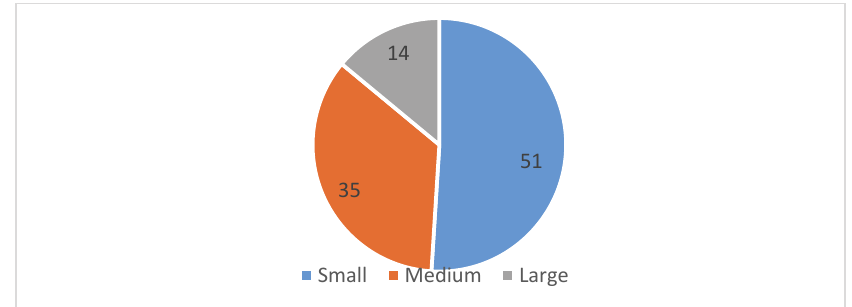
Fig. 1. Classification of surveyed enterprises by